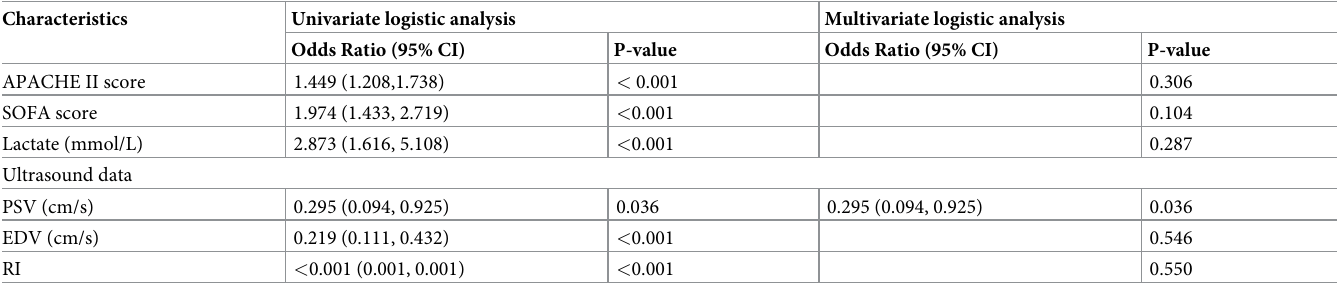
Table 2. Univariate and multivariate logistic